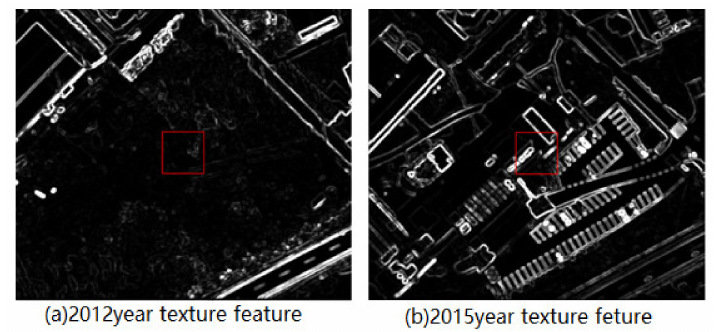
Figure 7. Texture feature.